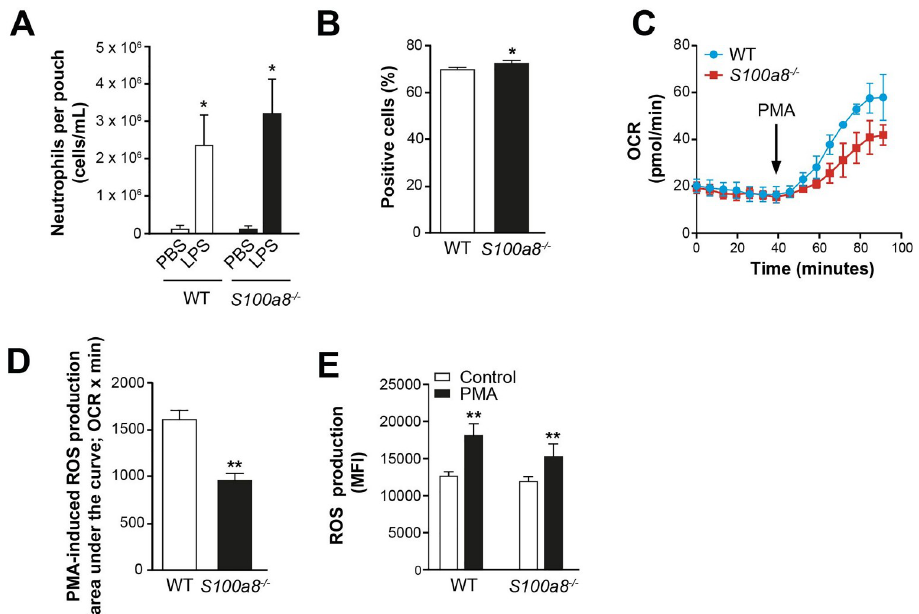
Fig 2. Deletion of S100a8 gene has limited effects on myeloid cell functions. (A) Neutrophil migration to the dorsal air pouch 6 h after LPS injection (10 mice). (B) Phagocytosis of monocytes. Values are percentage ± sem of fluorescein- labelled monocytes (4 mice). (C, D) Oxygen consumption rate (OCR) of bone marrow neutrophils in response to PMA, based on from 4 sample replicates from 1 representative experiment (out of 3). (E) ROS production measured as oxidation of the fluorogenic probe CellROX by neutrophils in response to PMA as measured by flow cytometry (n = 5). All values are mean ± sem. � p < 0.05; �� p < 0.01; ��� p < 0.001; ��� p < 0.0001, Student’s t-test.